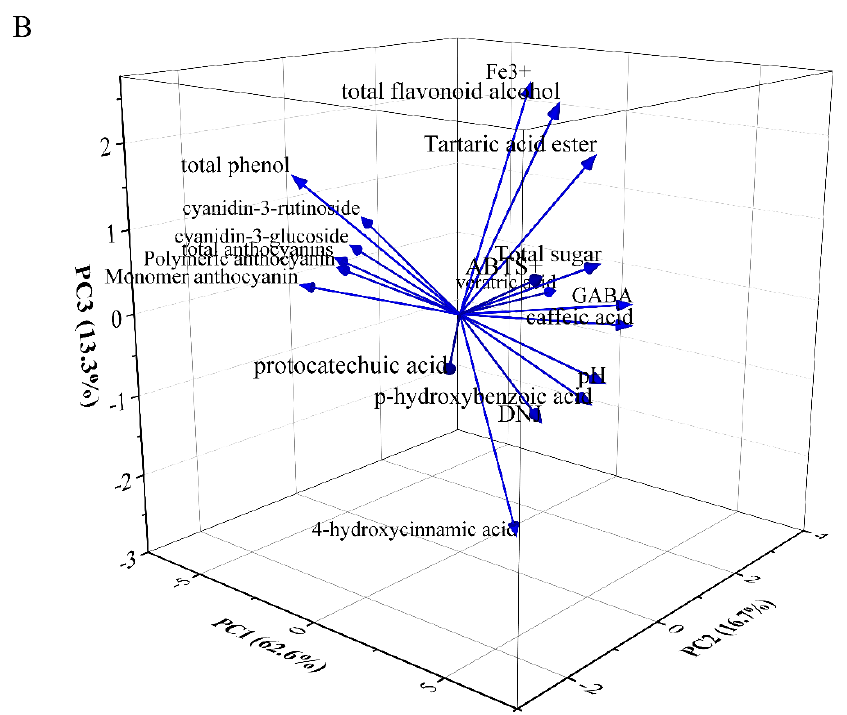
Figure 4. Principal component analysis of the four mulberry fermented alcoholic beverages containing mulberry leaf powder during fermentation. Score plots ( A ) and loading plots ( B ). Control represents without the addition of mulberry leaves; 1, 2 and 3% ( w / v , g/mL dry weight) represent the added amount of mulberry leaf powder.